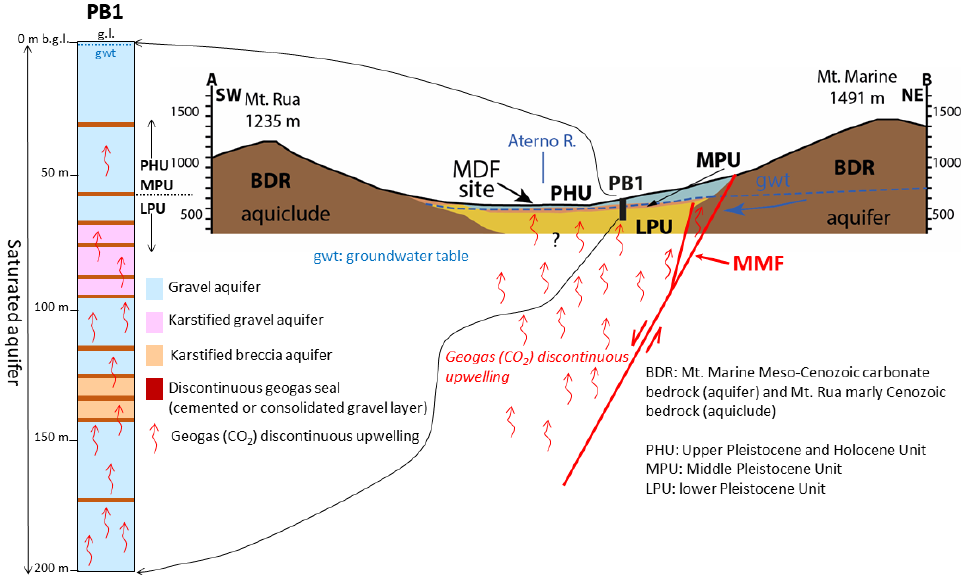
Figure 23. Unscaled hydrogeological sketch illustrating the gas upwelling hypothesis. BDR: Bedrock; MDF: Madonna delle Fornaci; PHU: Upper Pleistocene and Holocene Unit; MPU: Middle Pleistocene Unit; LPU: Lower Pleistocene Unit.